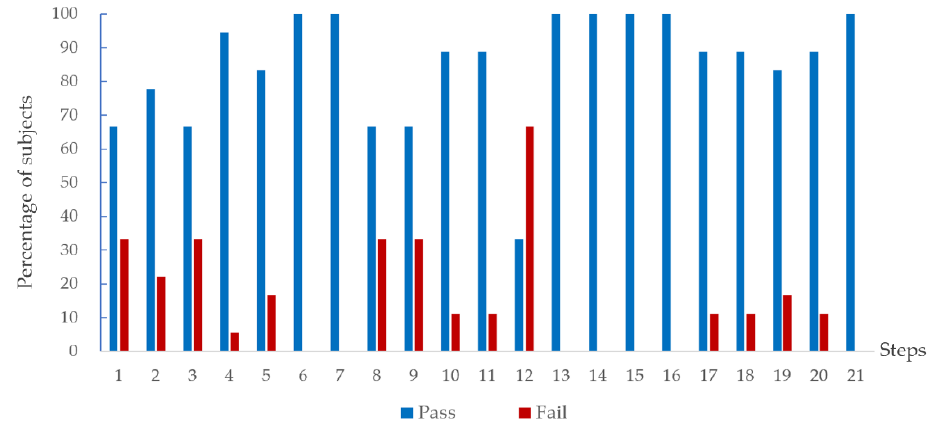
Figure 11. Percentage of passed and failed subjects at each step of barista education.